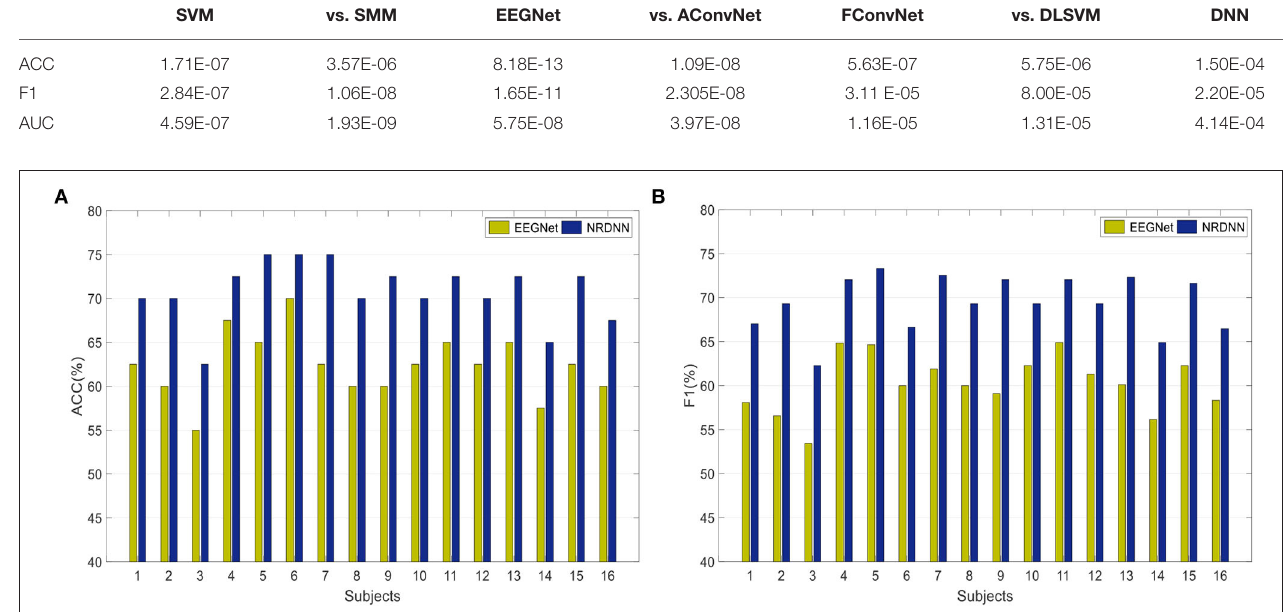
generality, we only take the first half subjects to evaluate the effectiveness of the proposed NRDNN, in order to reduce the training